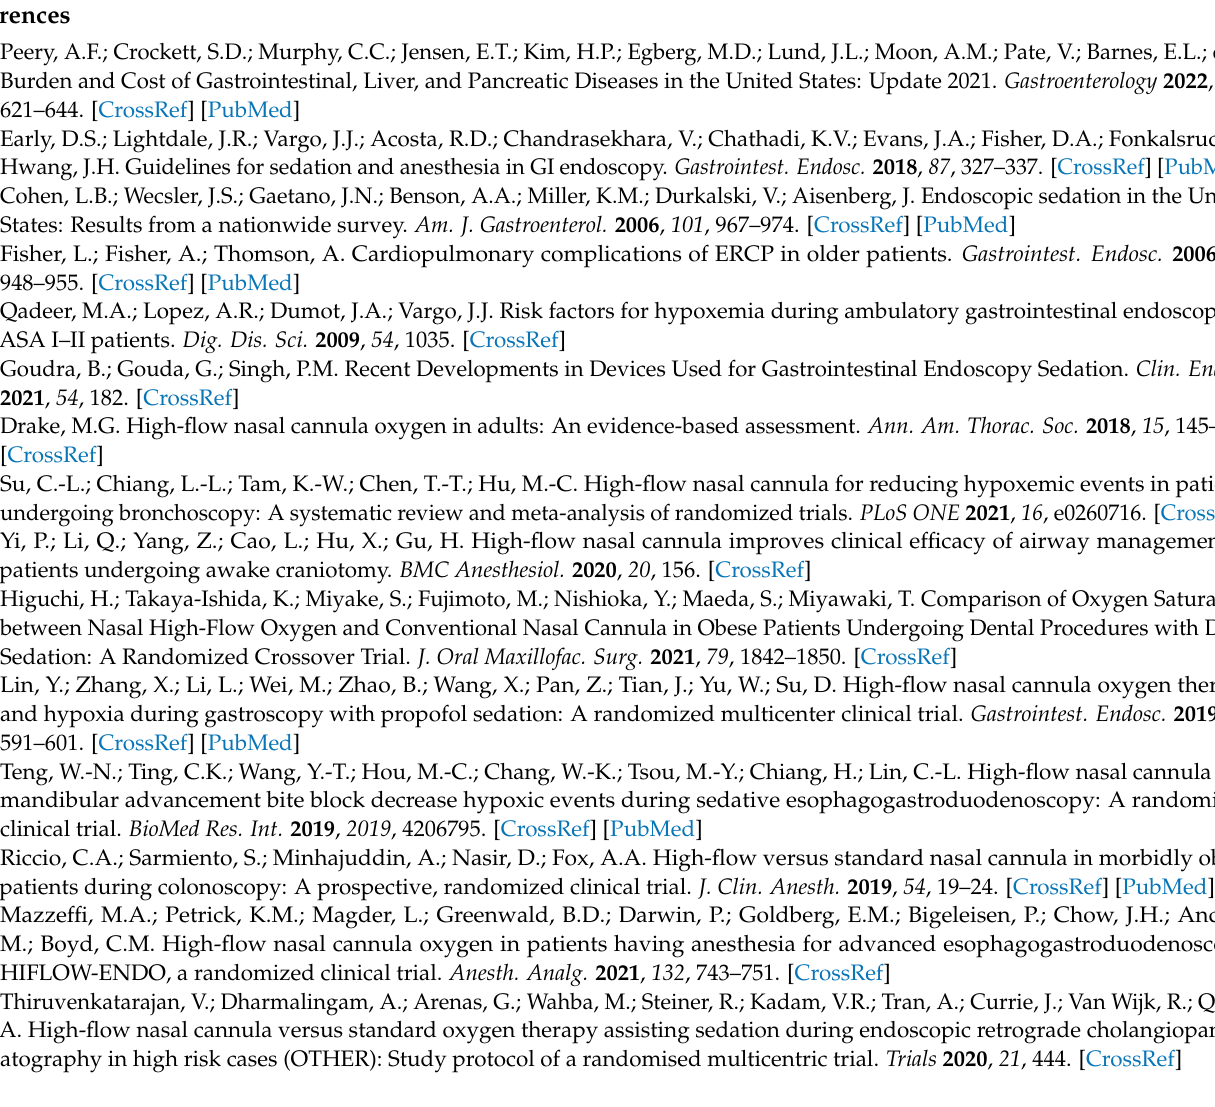
Figure A11. Bayesian random effect consistency model Outcome: Duration of procedure.